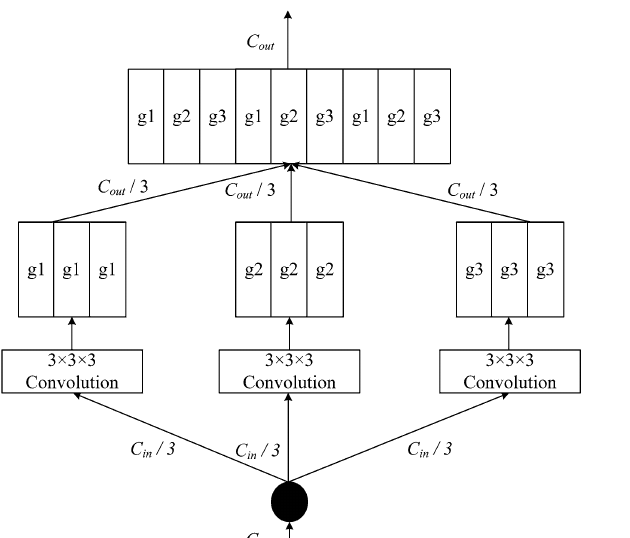
Fig. 3 Grouped interleaved convolution structure